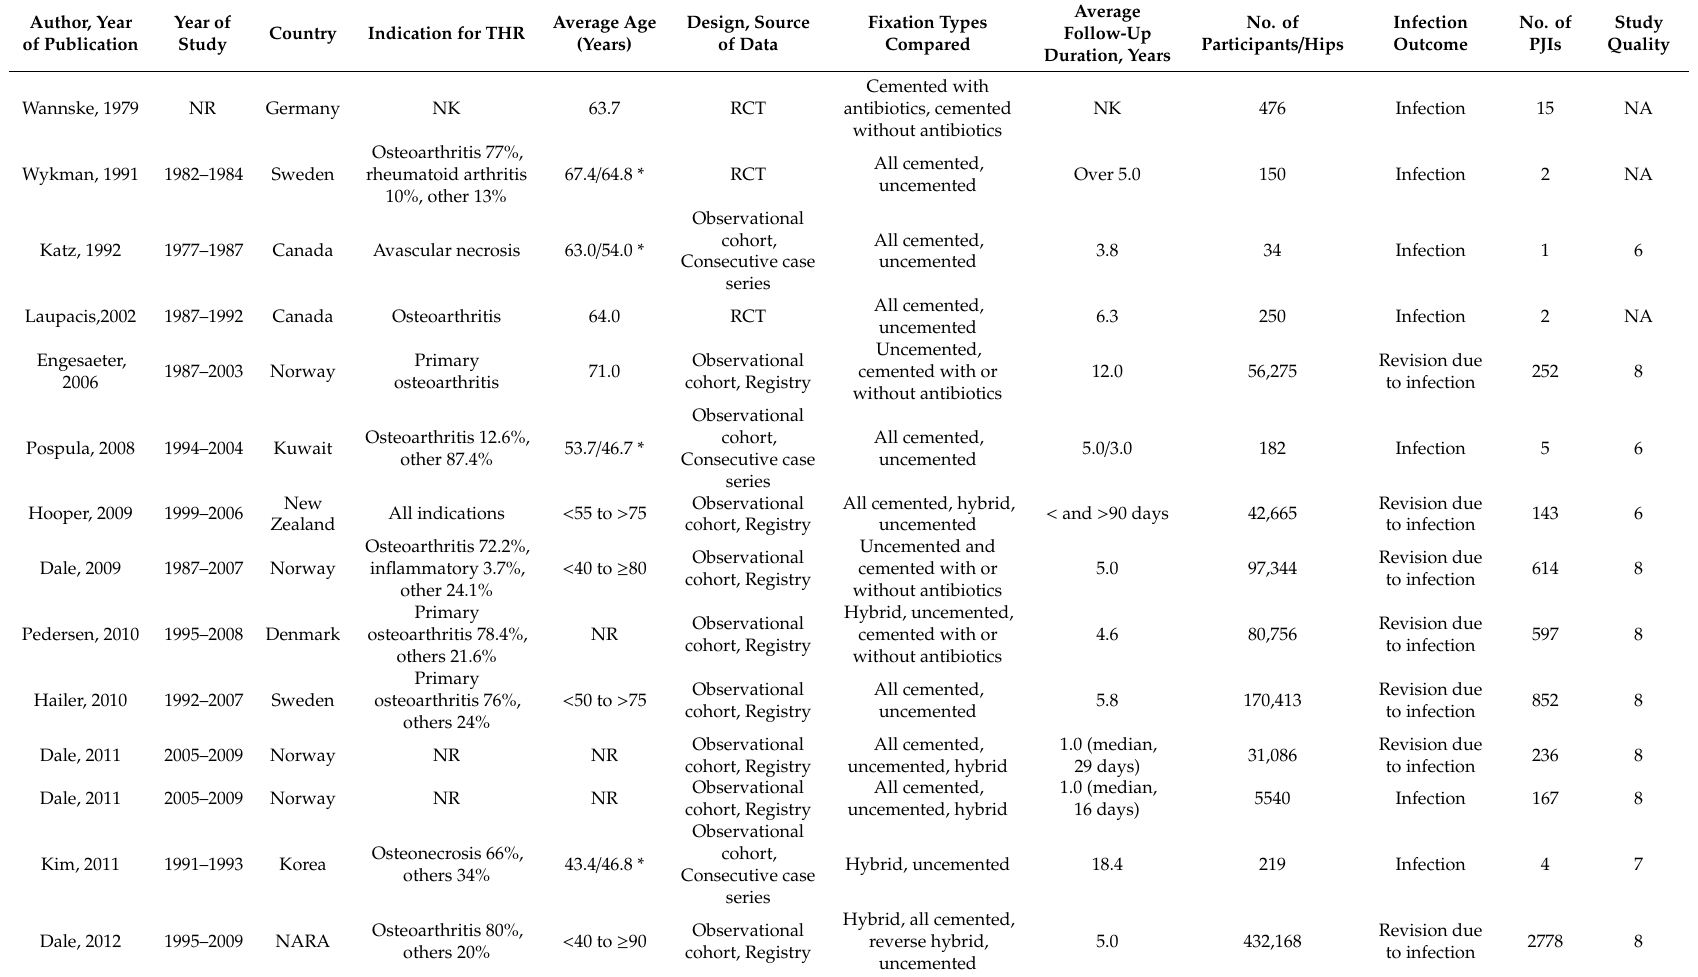
Table 1. Characteristics of studies included in